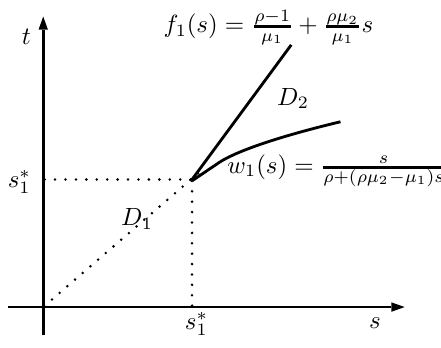
Figure 1. Partition of ( 0, ∞ ) 2 into D 1 , D 2